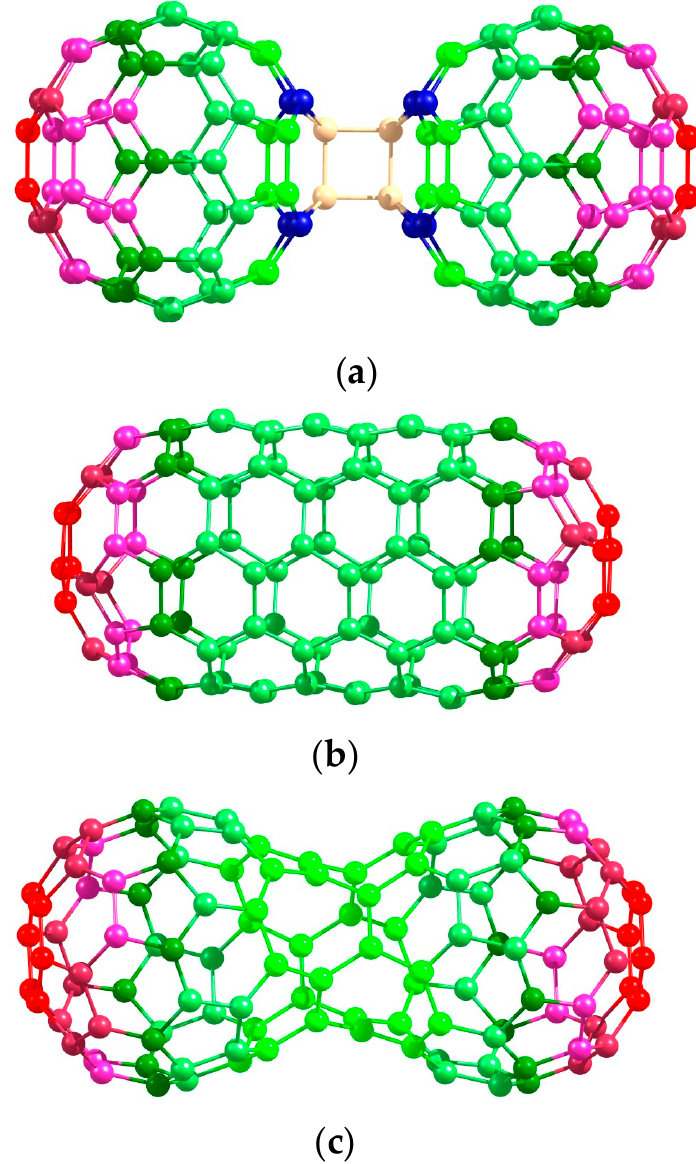
Figure 5. The distributed polarizability maps of the (C 60 ) 2 dimer ( a ) and its isomers, tubular fullerene ( b ), and nanopeanut ( c ). The color code is the same with Figure 4.